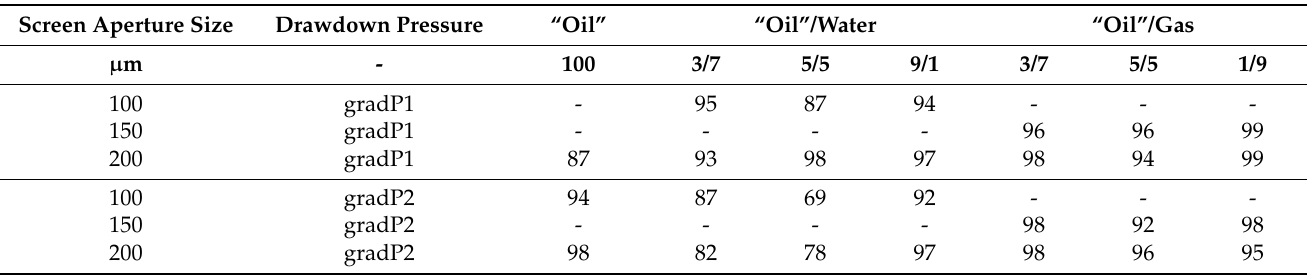
Table 3. Permeability change for PSD A during experiments. The number in the table is % of initial permeability of the system. Dash indicates no value (was not able to evaluate).